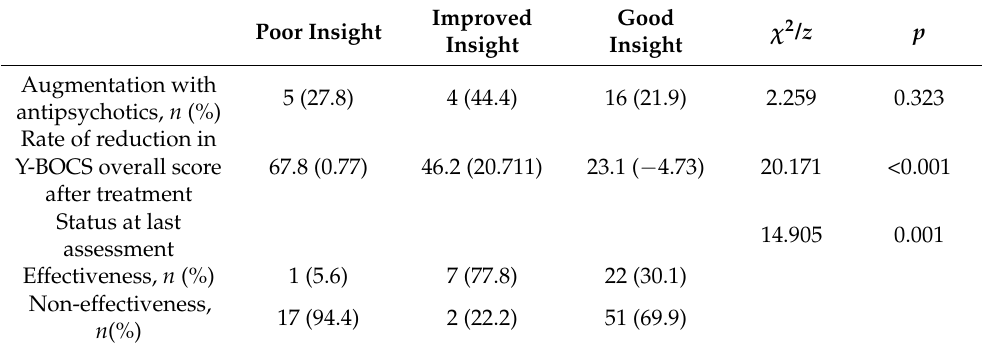
Table 3. Correlation between treatment response-related variables and insight after